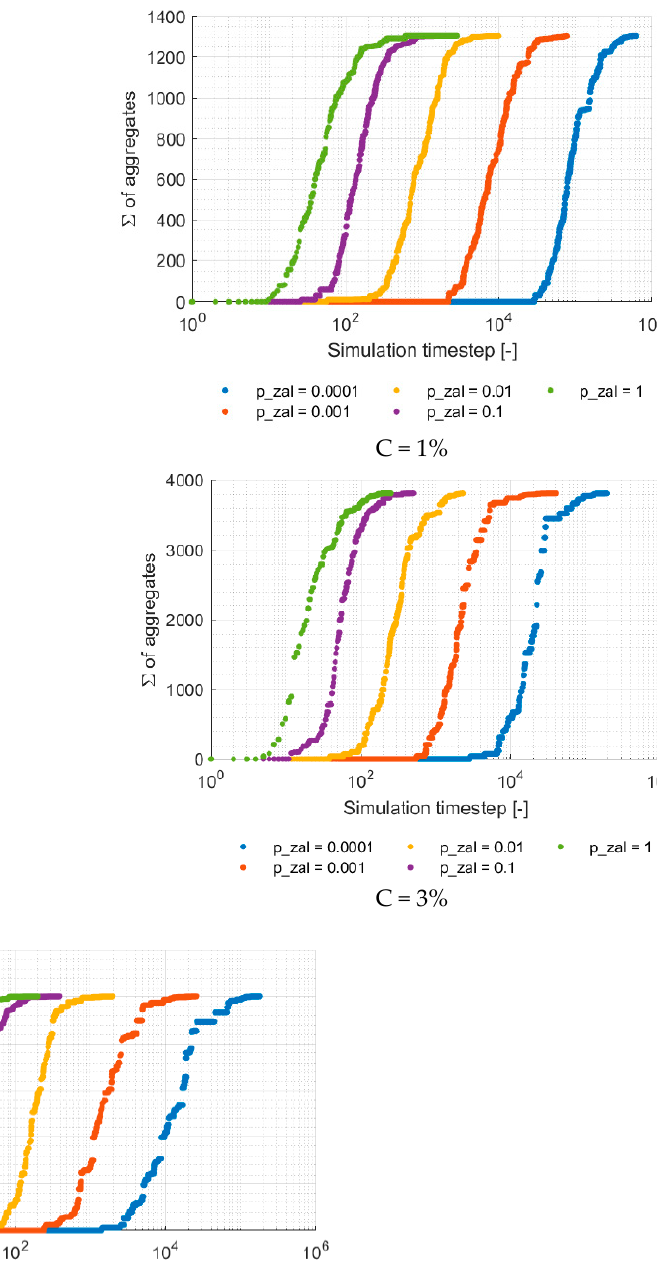
Figure A1. The numerically obtained structures for various secondary particle concentration (hor- izontal axis) and probability of an effective collision (vertical axis)—all 25 cases.